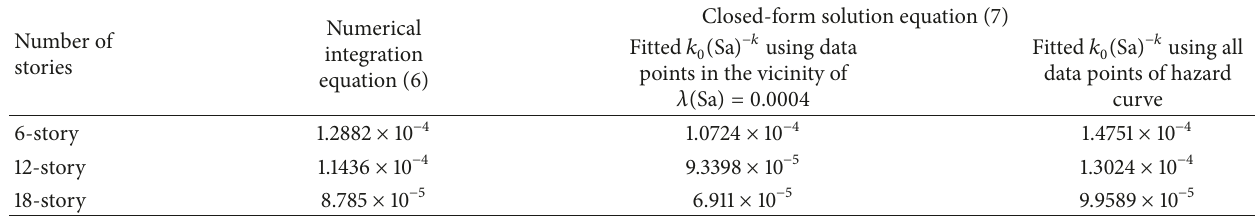
Table 6: Comparison between MAF of collapse obtained from (6) and (7) in studied building with fixed base. Number